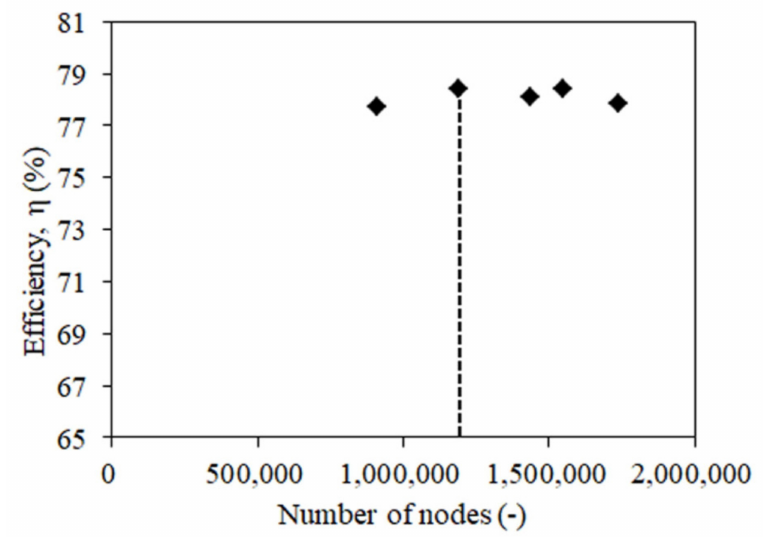
Figure 7. Grid independency test of the tubular turbine (vertical dotted line represents the used grid).